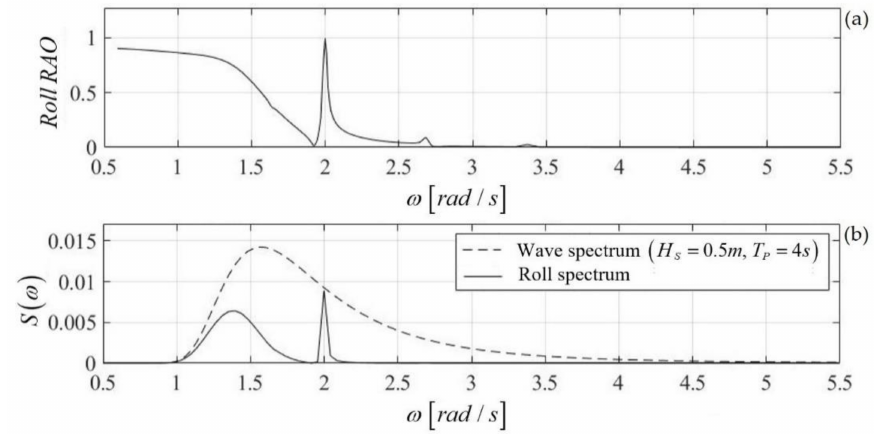
Figure 9. ( a ) Roll response of the floating twin-hull structure of breadth B = 20 m at a mean depth h = 30 m. ( b ) Incident wave spectrum (dashed line) and roll angle spectrum (solid line) of the structure in the case of incident waves with a significant wave height H S = 0.5 m and a peak period T P = 4 s.